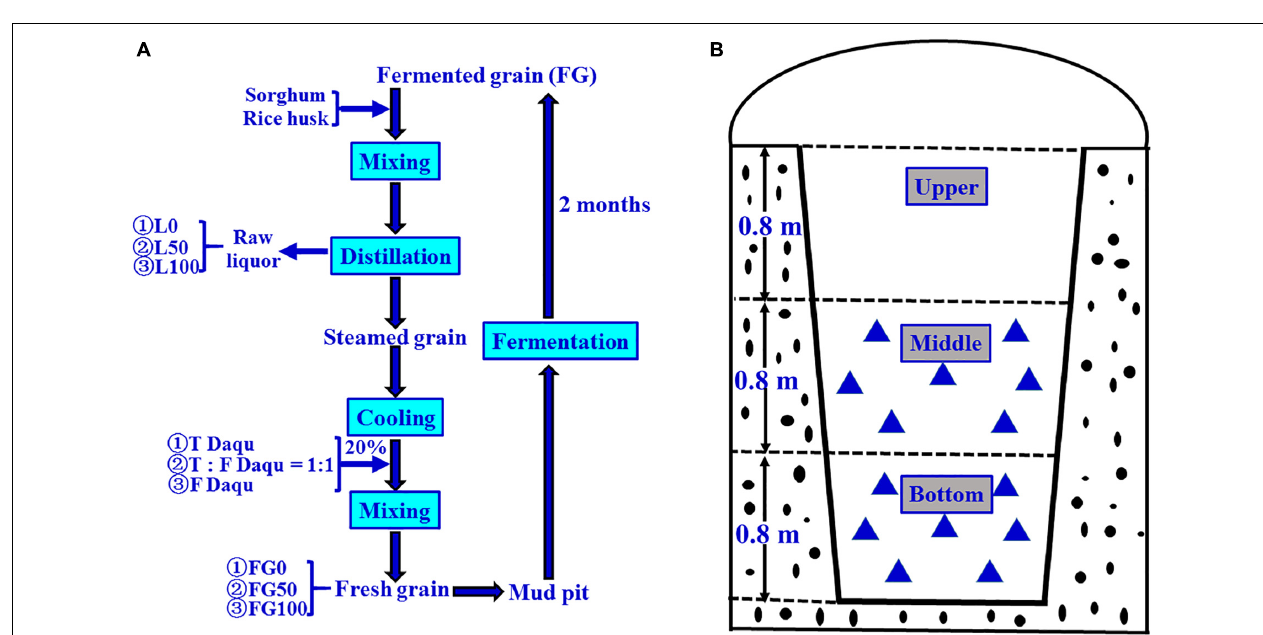
FIGURE 1 | Manufacture process of fortified Daqu .